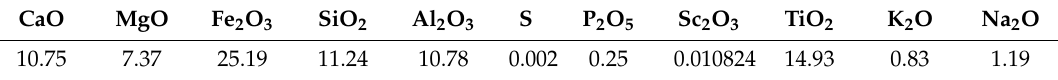
Table 4. Main chemical composition analysis results of hydrolysis residue (wt